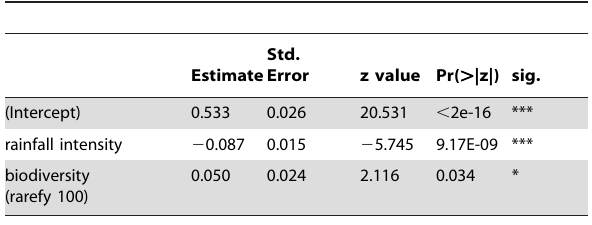
Table 3. Effects influencing the standard deviation of throughfall kinetic energy